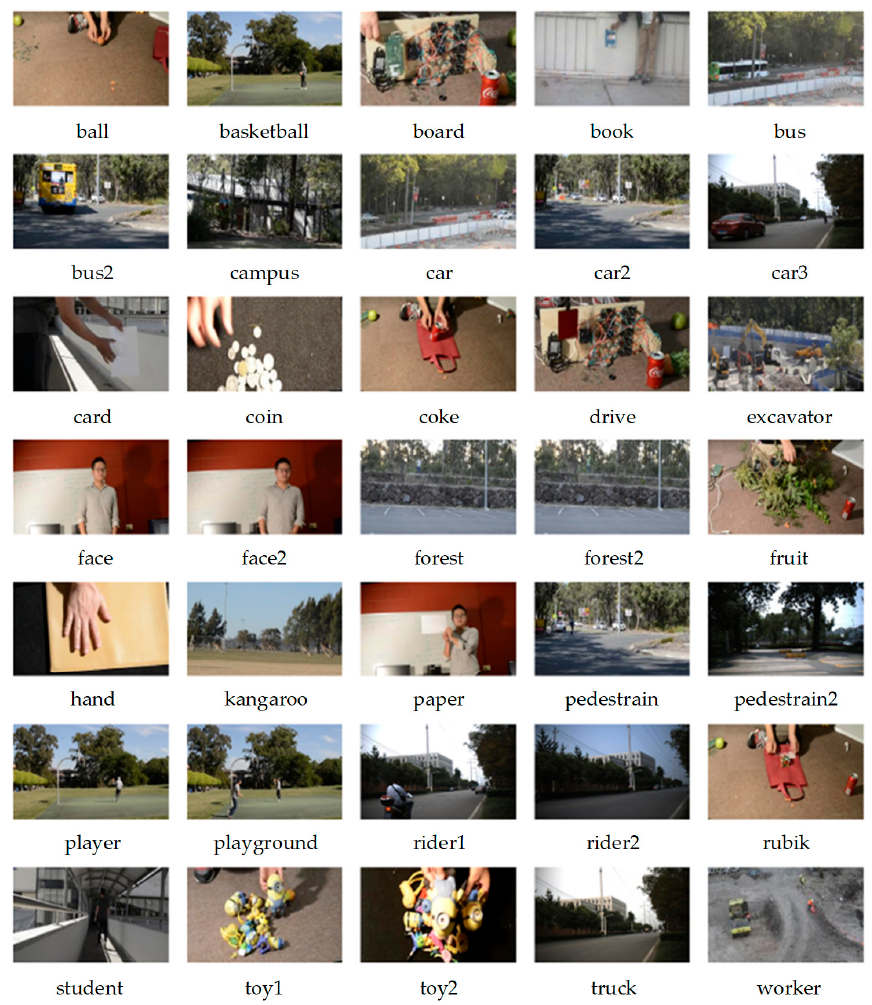
Figure 2. Hyperspectral video dataset scenes [33].